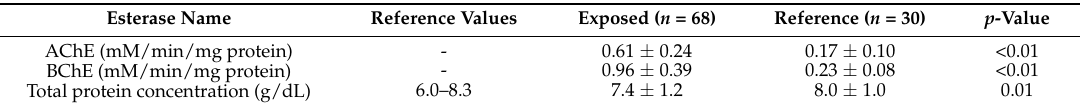
Table 4. Esterase enzyme activity and biochemical results comparison between the exposed and reference